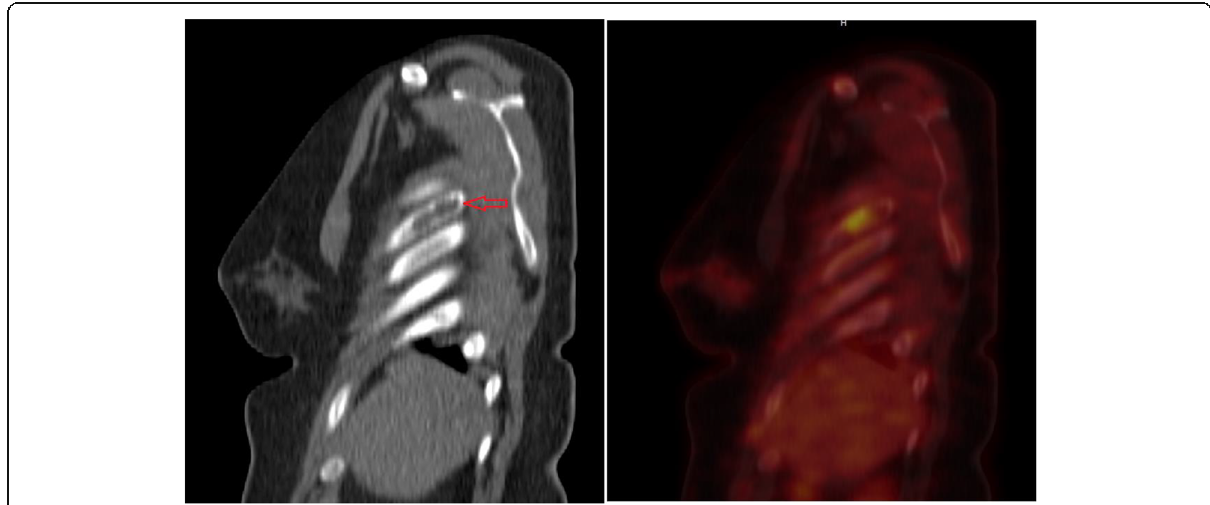
Fig. 5 Sagittal computed tomography image and sagittal fused 18 F-FDG PET/CT image: There is FDG-avid lytic lesion in lateral curvature of the left fourth rib